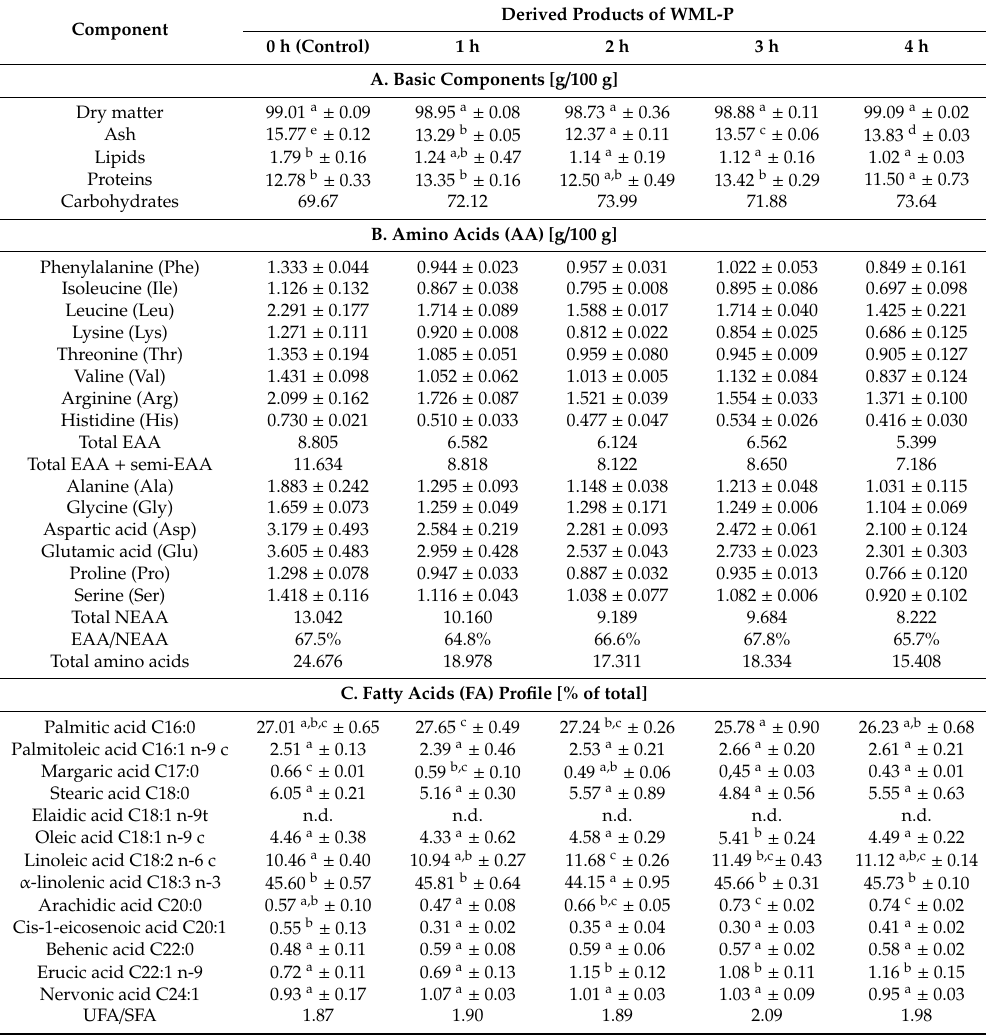
Table 1. The content of basic compounds, amino acids, minerals, dietary fiber fractions, fatty acids profile and chlorophyll in dried Polish var. zolwinska wielkolistna leaves (WML-P) before (control) and after